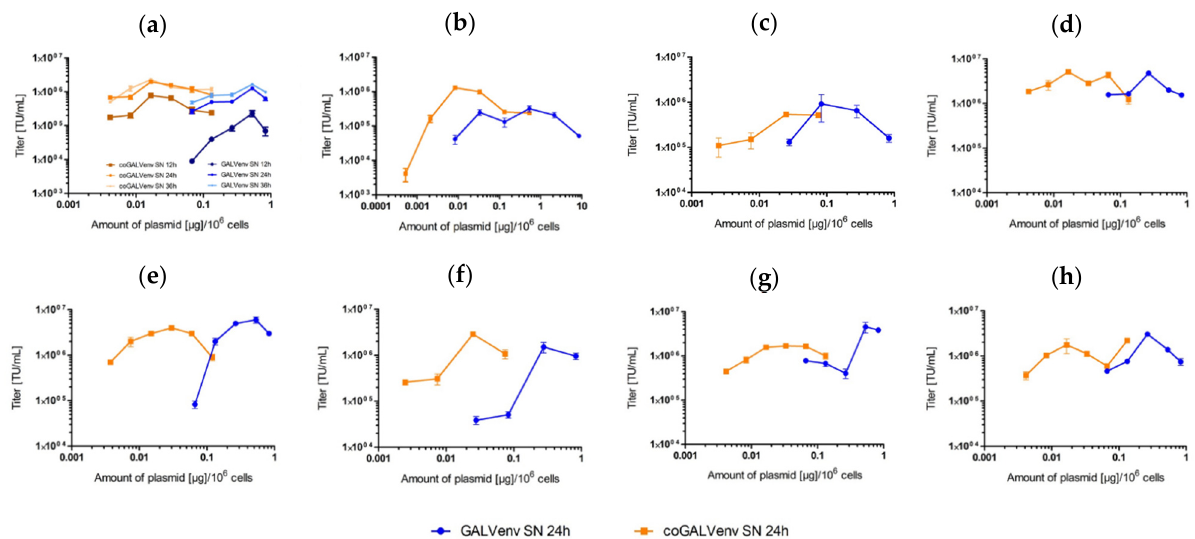
Figure 1. Comparative titration of lentiviral LeGO-mOrange2 vectors produced with standard vs. codon-optimized (co) GALV-env. ( a ) Much lower amounts of coGALV-env as compared to GALV-env were required to obtain maximal titers. Supernatants were harvested 12, 24, and 36 h after transfection of 293T cells. As evident, maximal titers were in all cases obtained with >20 times lower amounts of coGALV-env as compared to GALV-env; ( b – h ) titration experiments for seven additional, independent vector productions (only the 24 h data point is shown). Means and standard deviations of triplicates are shown. Small error bars are part hidden behind data point symbols.